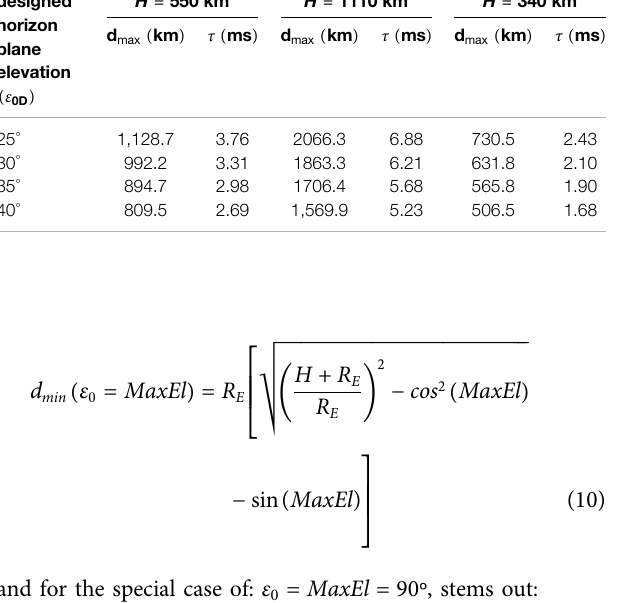
TABLE 2 | Maximal distance and one-way signal delay for the different shells. The